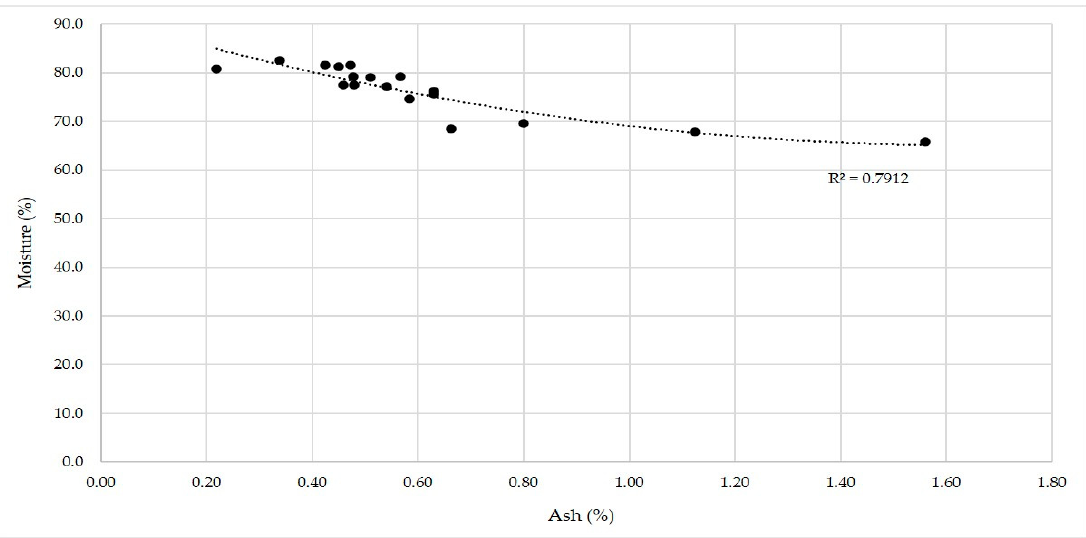
Figure 3. Relation between fruit moisture content (%) and ash content (%) of the fruits of the 18 genotypes of jujube tree studied. (Mean values, n = 40.).